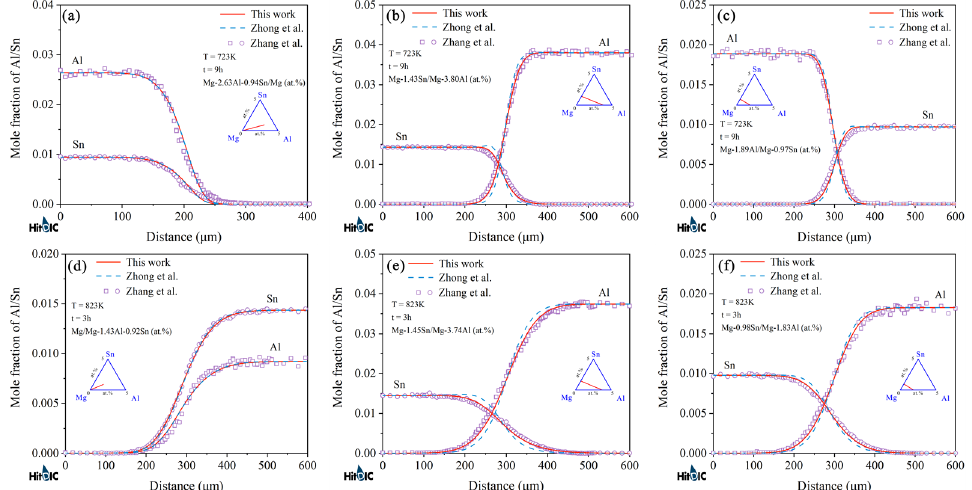
Figure 9. Model-predicted composition–distance profiles of the different hcp Mg–Al–Sn diffusion couples annealed at ( a – c ) 723 K for 9 h and ( d – f ) 823 K for 3 h from the present atomic mobilities (solid lines) compared with these of Zhong et al. [32] (dashed lines) and the experimental data [34] (in symbols).